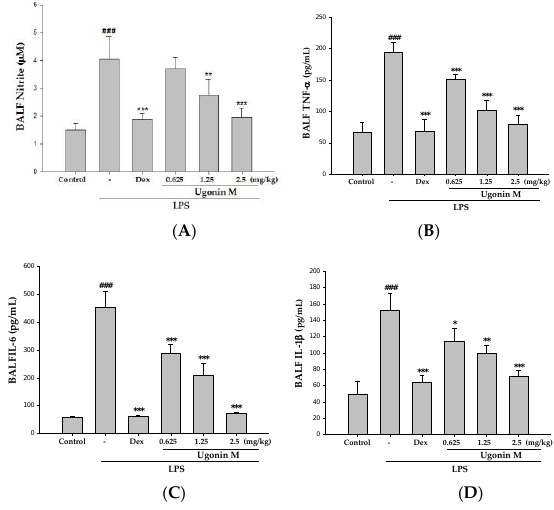
Figure 6. Effects of Ugonin M on: ( A ) NO; ( B ) TNF-α; ( C ) IL-6; and ( D ) IL-1β in BALF. Data represent the mean ± SD of six mice. ### p < 0.001 was compared with a sample of the control group (One-way ANOVA followed by Scheffe’s multiple range tests). * p < 0.05, ** p < 0.01, and *** p < 0.001 were compared with the LPS-only group.